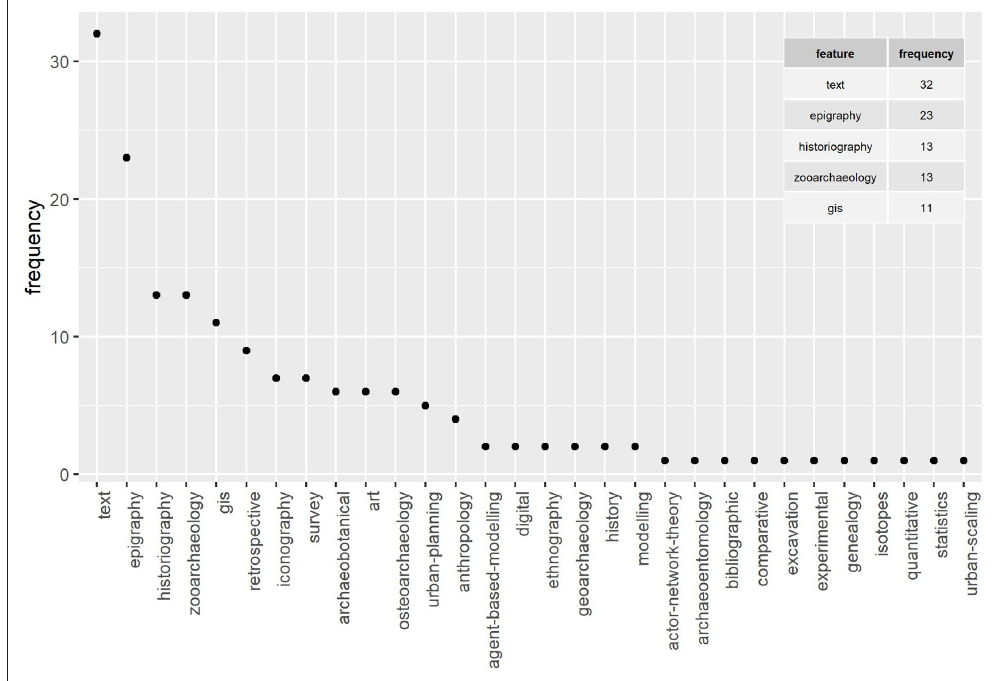
Figure 6: Word frequency plot for ‘method’ key words (inset table – five most frequent